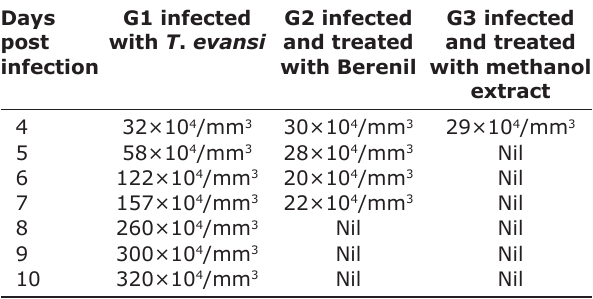
Table-1: Course of parasitemia in mice experimentally infected with T. evansi over the 10 days of the